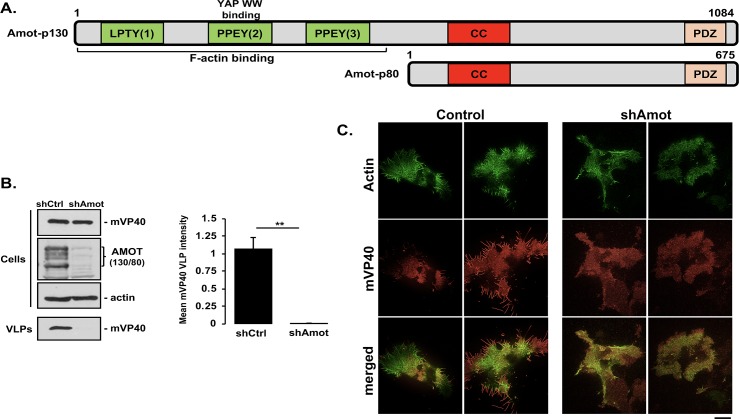
VP40 VLP budding assay in AMOT control (shCtrl) or AMOT knockdown (shAmot) cells.A) Schematic diagrams of full-length angiomotin (Amot-p130) and N-terminally truncated angiomotin (Amot-p80) with key domains highlighted. Numbers represent amino acids. LPTY(1), PPEY(2), and PPEY(3) = three PPxY motifs; CC = coiled coil domain; PDZ = PSD-95/Dlg1/ZO-1 domain. B) AMOT expressing (shCtrl) or knockdown (shAmot) cells were transfected with mVP40 (0.25μg) and the indicated proteins were quantified in cells and VLPs by Western blotting and NIH Image-J, respectively. The bar graph represents data from at least three independent experiments. ** p<0.01. C) shCtrl or shAmot cells were transfected with 0.5μg each of pCMV-LifeAct-RFP and YFP-mVP40 plasmids, and cells were imaged by TIRF microscopy at 24 hours post-transfection. Two representative images of F-actin alone (green), YFP-mVP40 alone (red), and merged images for both shCtrl and shAmot cells are shown. Scale bar = 10 μm.